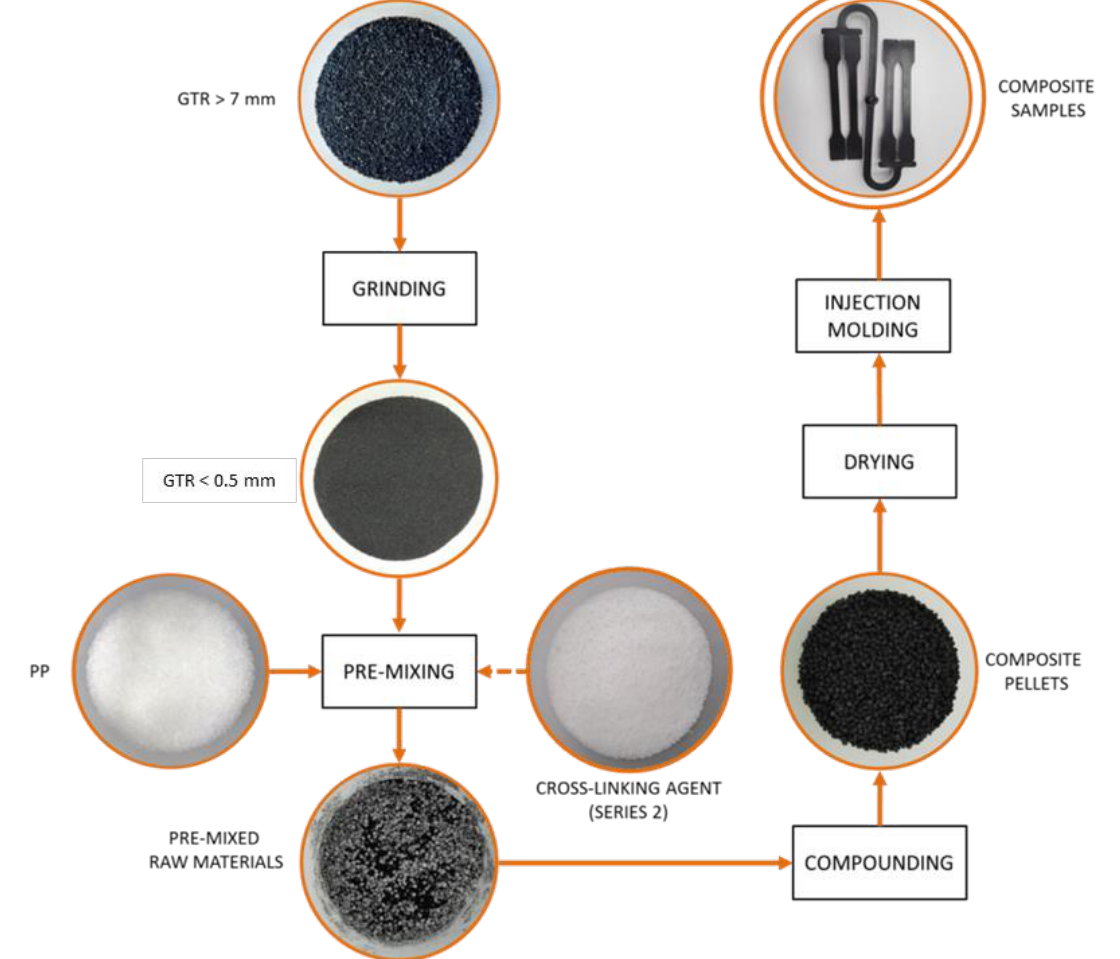
Figure 4. Diagram of the preparation of PP/GTR samples .